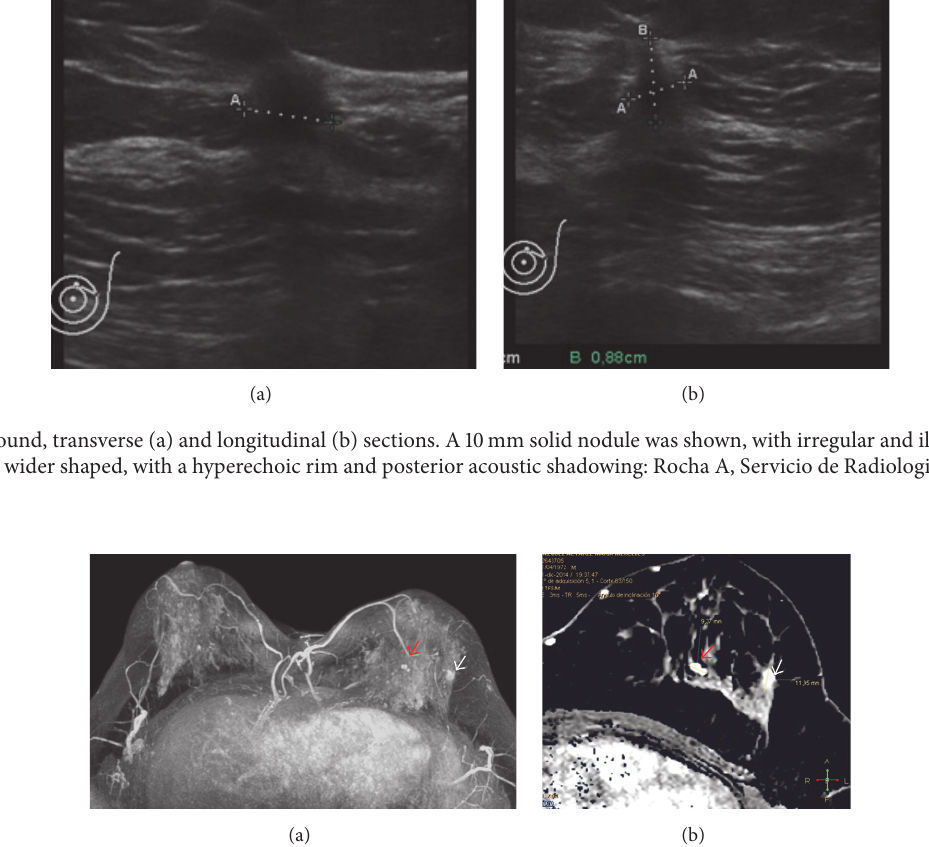
Figure 4: Breast Magnetic Resonance T1-weighted images, after gadolinium administration and axial maximum intensity projection (MIP) reformations. In addition to the previously biopsied lesion in the upper outer quadrant, there was another nodule 35 mm apart, in the upper inner quadrant. It measured 8mm and was also submitted to US-guided biopsy: Rocha A, Servicio de Radiologia, Hospital Povisa, Vigo,